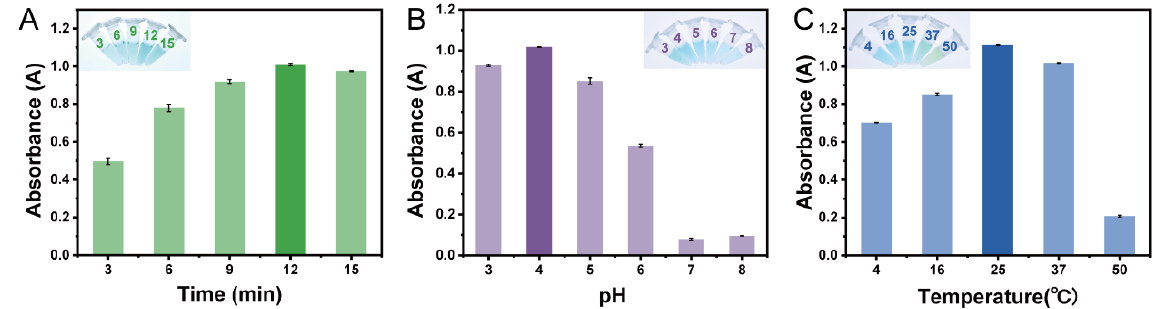
Figure 2. The effect of experimental conditions included ( A ) reaction time (1 – 15 min), ( B ) pH value (3 – 8) and ( C ) reaction temperature (4 – 50 °C) on the catalytic activity of MoS 2 -CPBNPs nanozymes towards TMB oxidation by H 2 O 2 .